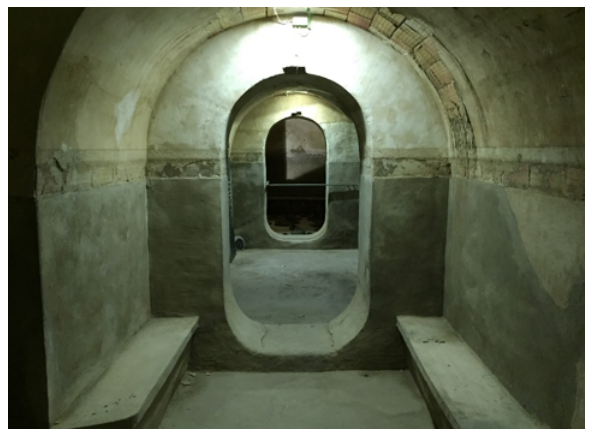
Figure 8. One of the two main halls, where the three cells of this one are distinguished, being the distribution center.